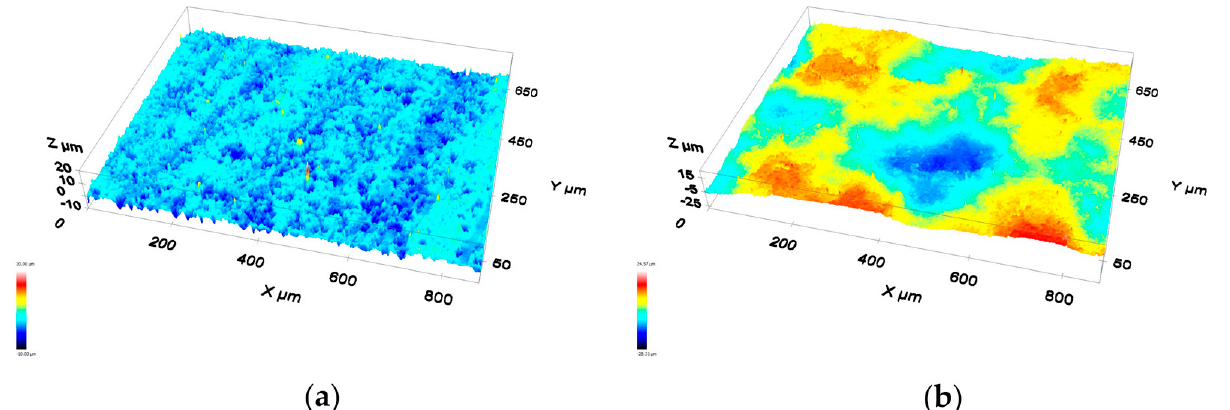
Figure 2. Three–dimensional noncontact profilometry images of the two planar substrates: ( a ) H-C22 and ( b ) alumina.